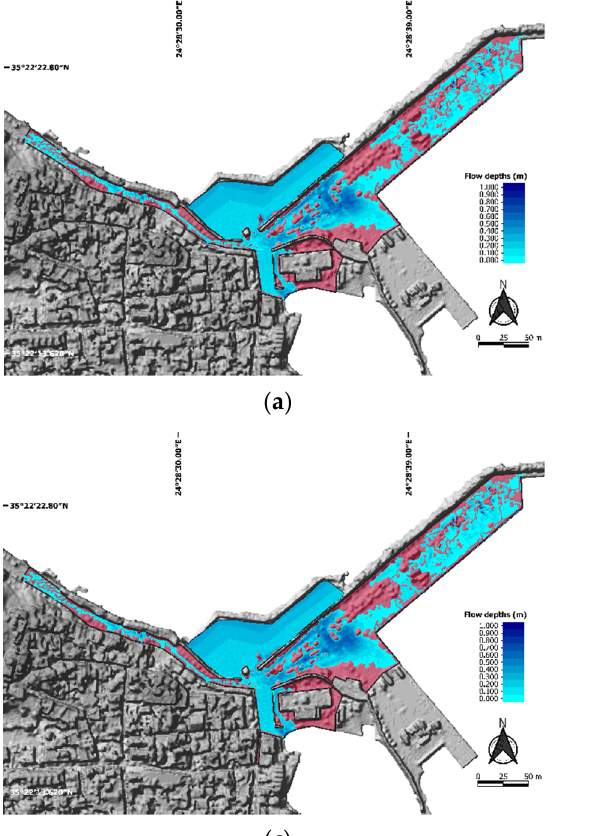
Figure 5. Maximum inundated area (highlighted with red color) from video recordings and local stakeholder observations.